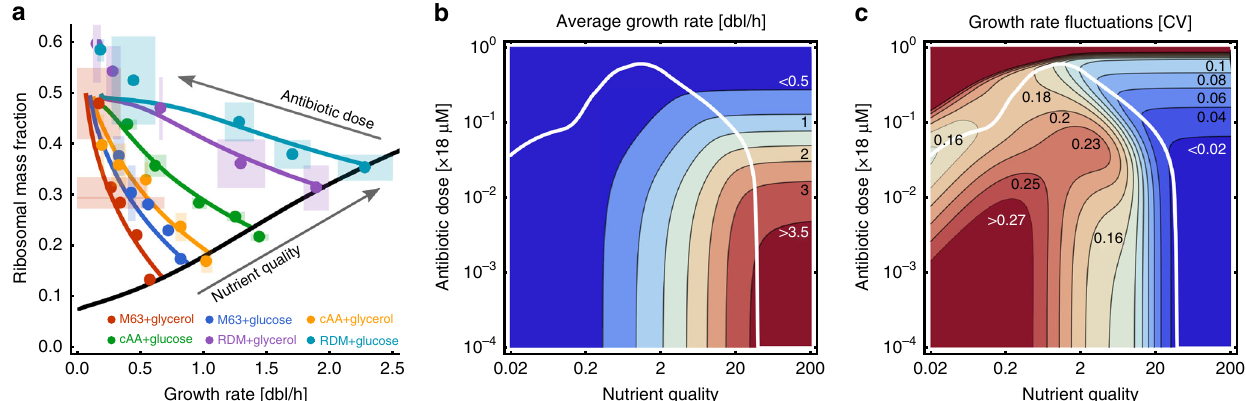
Fig. 5 Condition-dependence of antibiotic responses. a Ribosomal content per cell as a function of average growth rate after treatment with chloramphenicol. Predictions (solid lines) are in quantitative agreement with experimental data 9 (dots, shaded areas denote standard deviations over replicates and colours denote different nutrient conditions). b For any given nutrient condition the average growth rate is predicted to decrease monotonically with antibiotic dose. c Growth heterogeneity is predicted to be highly complex in a both nutrient- and dose-dependent manner. In nutrient- rich conditions growth heterogeneity increases with antibiotic dose, while in intermediate and poor conditions the response is non-monotonic. Over a large range of nutrient conditions there exists a non-zero drug dose that minimises growth heterogeneity (solid white line, b , c